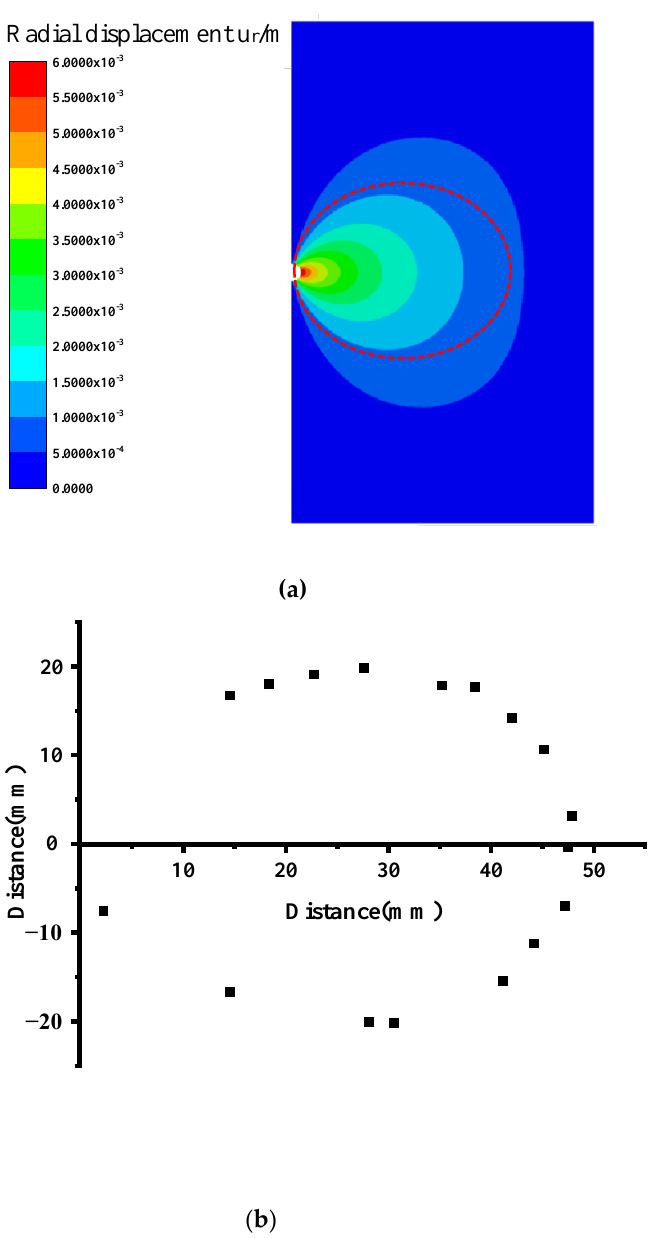
Figure 9. Action range diagram of numerical simulation bolt. ( a ) FLAC3D simulation diagram. ( b ) Contour map.